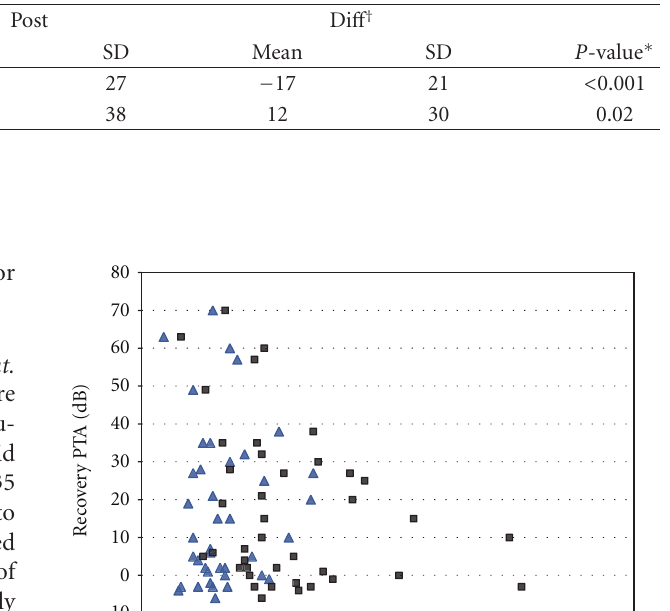
Table 3: Average pre- and post-treatment PTA and SDS.